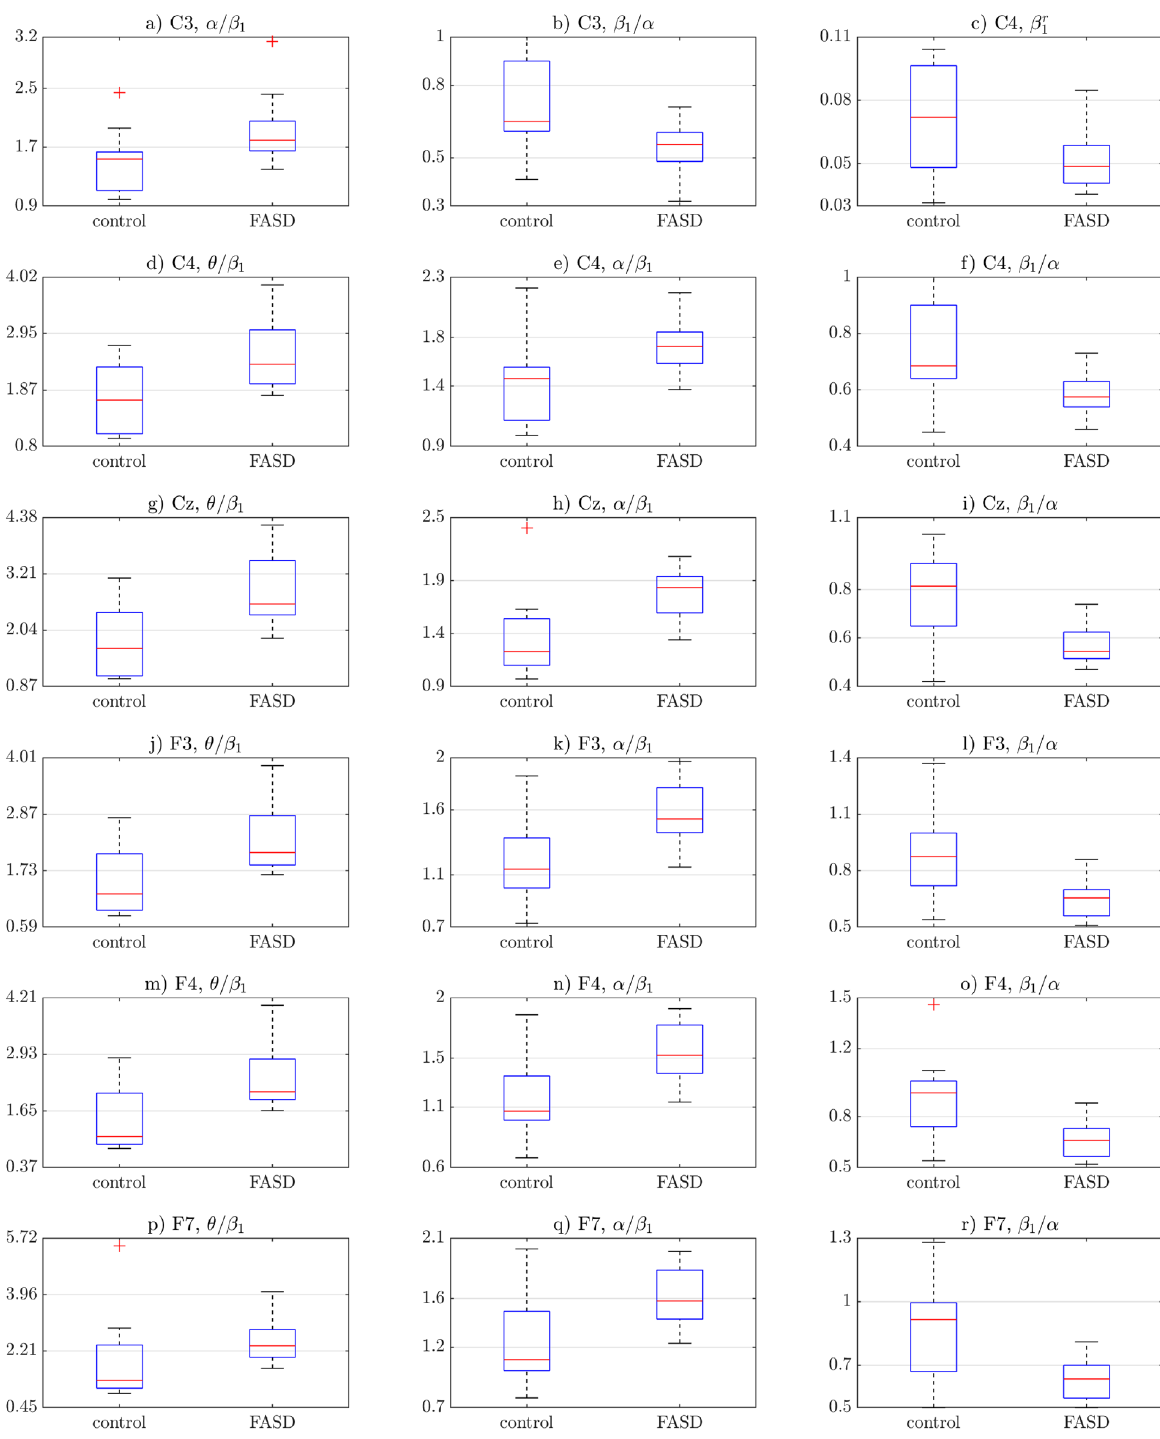
Figure 1. The first part of statistically significant features’ boxplots. Blue box indicates the interquartile range, while whiskers indicate the rest of the values not considered outliers. Outliers are marked with red crosses and red lines show the median. See the second part on Fig.